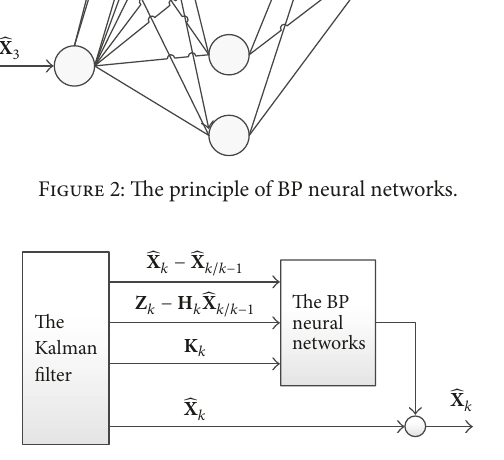
Figure 3: The principle of Kalman filters with neural